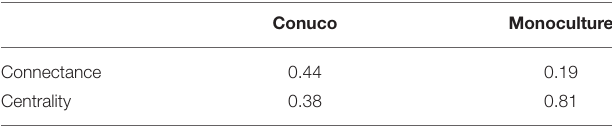
TABLE 2 | Connectance and centrality values for Conuco and corn Monoculture networks in Figure 2 .